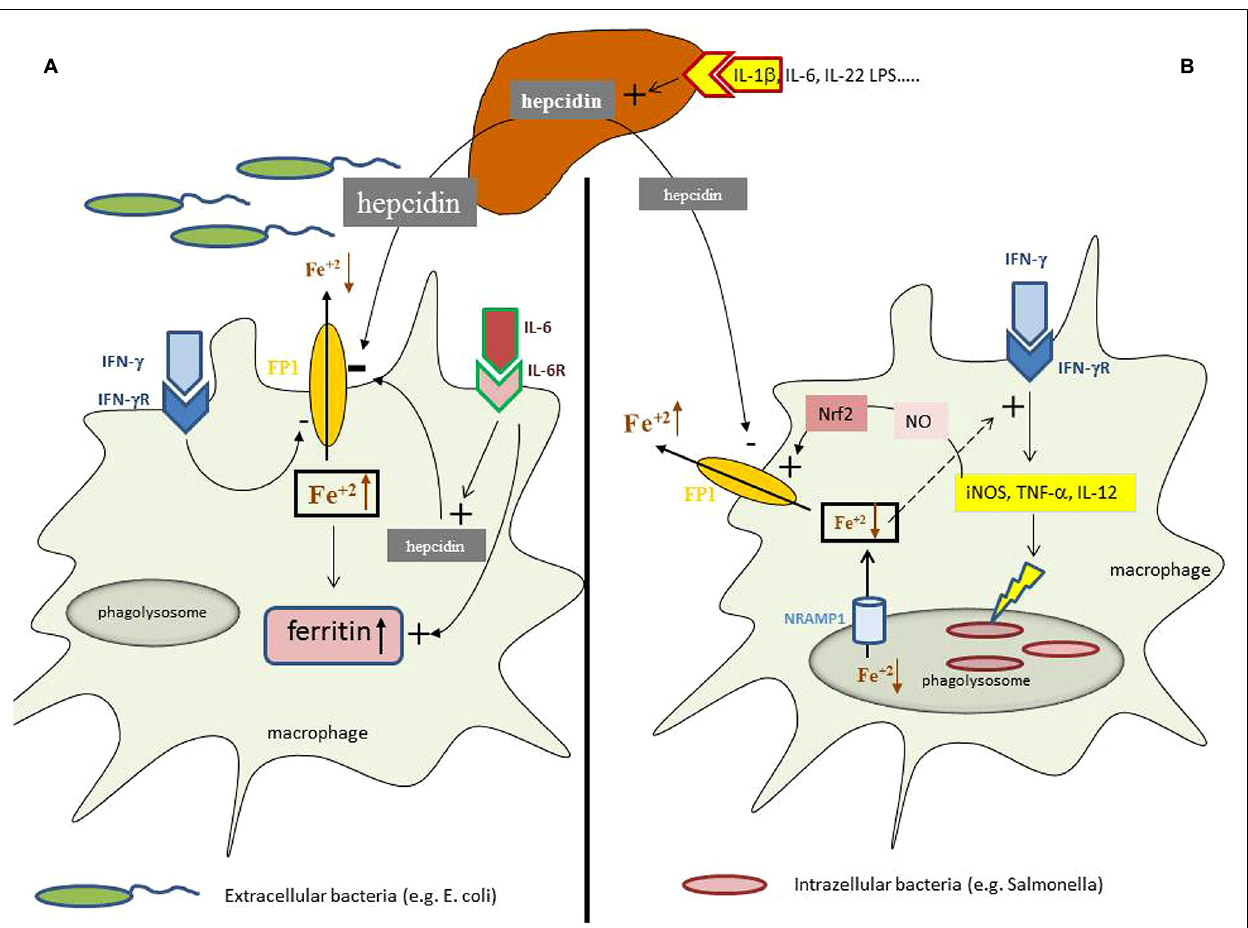
FIGURE 1 | Iron homeostasis in differently regulated depending on the primary localization of the pathogen. During an inflammatory process cytokines and bacterial products can induce the formation of the master regulator of iron homeostasis, hepcidin, in the liver. (A) In case of infection with extracellular bacteria hepatocyte derived hepcidin targets ferroportin (FP1) on the cell surface and results in its degradation thereby reducing macrophage iron agrees. This effect is further supported by minute amounts of hepcidin produced by macrophages in response to interleukin-6 (IL-6) and by the action of interferon-gamma (IFN- γ ) which inhibits ferroportin expression transcriptionally. This results in systemic hypoferremia and reduced iron availability for extracellular bacteria whereas the increased intracellular amounts of iron in the cell are incorporated into ferritin, the expression of which is induced by iron and cytokines, such as tumor necrosis factor-alpha (TNF- α ), IL-1 β , or IL-6. (B) While in case of an infection with intracellular bacteria hepcidin also exerts negative effects on ferroportin